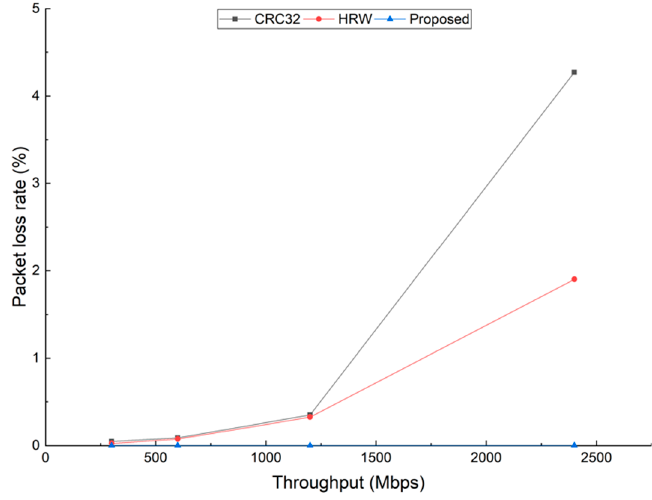
Figure 5. Packet loss rates under different throughputs when two cores are overloaded while others have no traffic.